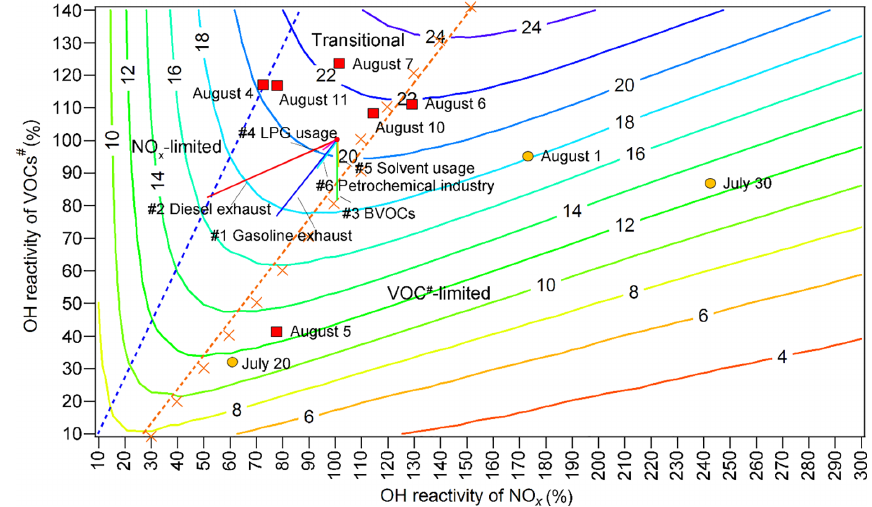
Figure 8. Isopleths of the net O 3 production rate (ppbvh − 1 ) at 12:00LT as a function of OH reactivity blocks and orange circles denote the calculated OH reactivity days, respectively. Each orange cross represents the OH reactivity O 3 production rate at a given OH reactivity regime, transitional regime and NO x -limited regime. Line 1 (solid straight blue line): gasoline exhaust; line 2 (straight red line): diesel exhaust; line 3 (straight green line): BVOCs; line 4 (straight pink line): LPG usage; line 5 (solid straight orange line): solvent usage; line 6 (straight light-blue line): petrochemical